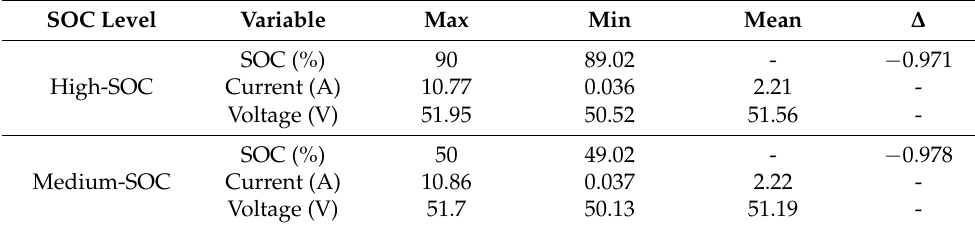
Table 1. High and medium SOC battery-only simulation data.